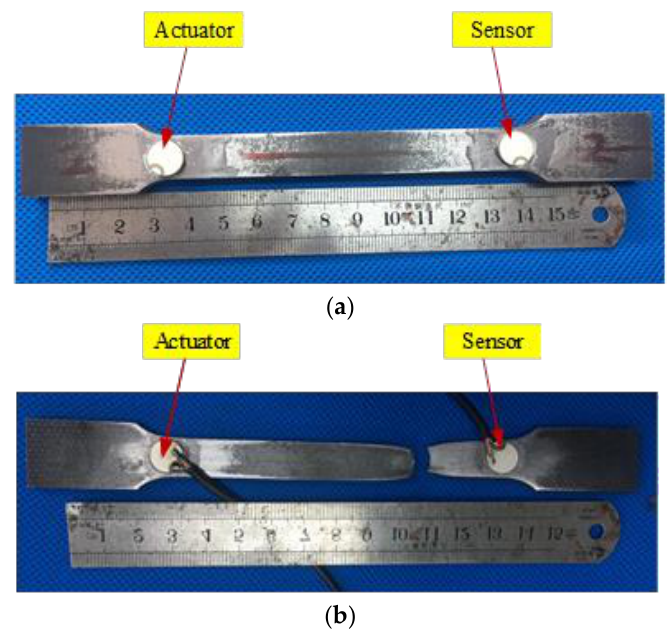
Figure 2. Tensile samples with two PZTs: ( a ) Before the test; ( b ) After the destructive tests.